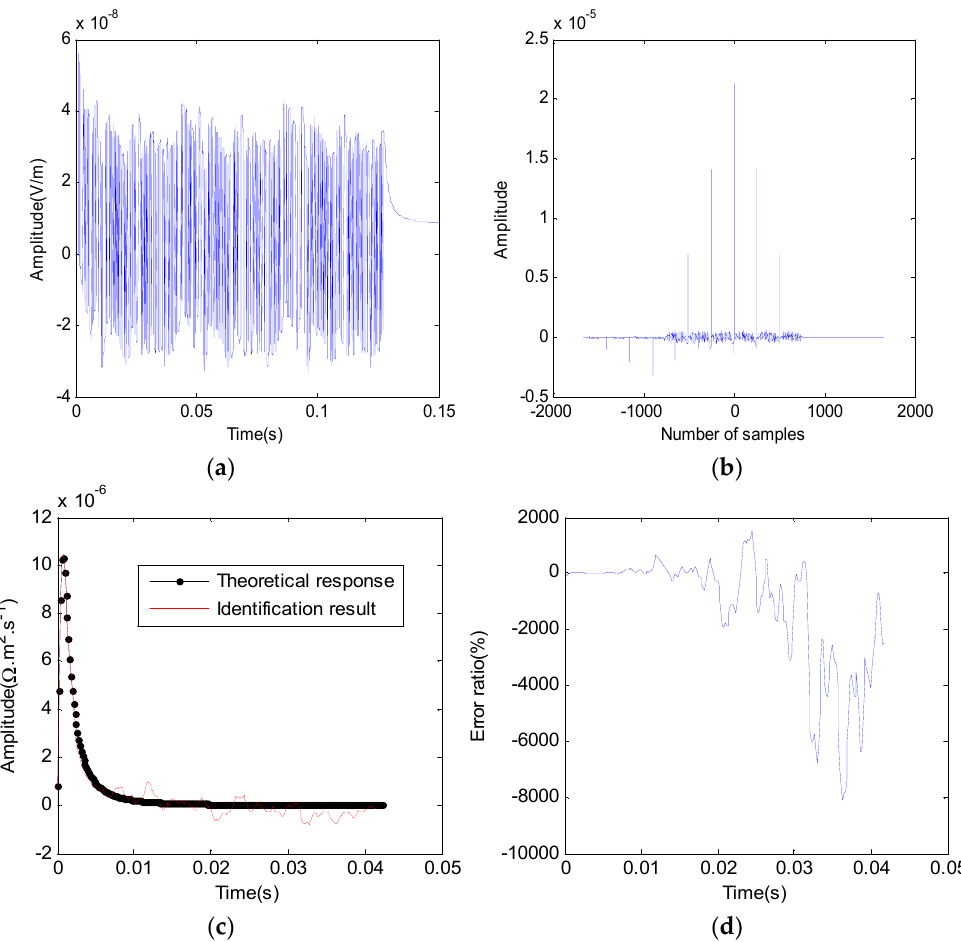
Figure 3. Identification results of linear convolution and linear correlation. ( a ) The field excited by pseudo-random sequences; ( b ) cross correlation of emission signals and response signals; ( c ) the earth impulse response extraction result; ( d ) the identification error.